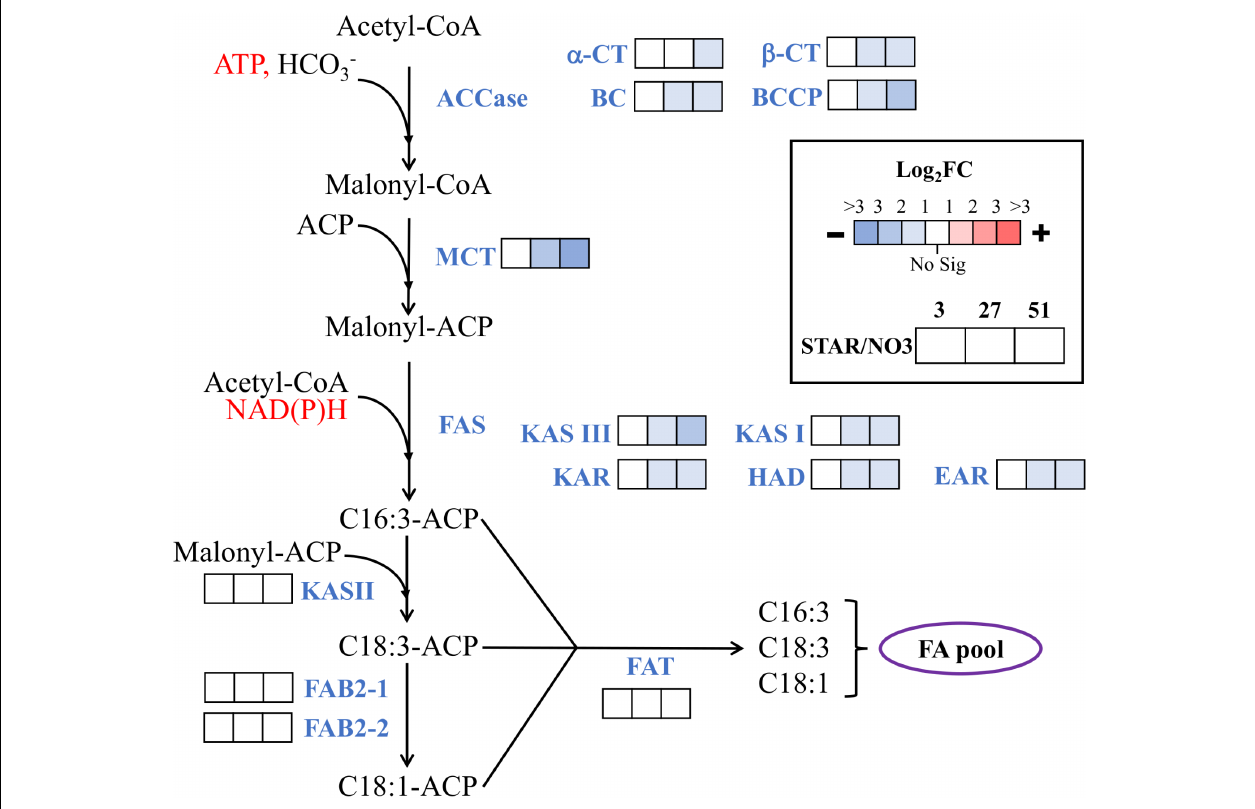
FIGURE 4 | Expression of fatty acid synthesis genes during nitrogen starvation. The log 2 fold change values are presented as STAR over NO3 for the 3, 27, and 51 h time points (left to right). Blue represents downregulation in comparison to NO3 and red is upregulation in comparison to NO3. White represents no significant differential expression. Fatty acids are labeled by the number of carbons:number of unsaturated bonds. Expression data and transcript identities are in Supplementary Data Sheet 1 . Abbreviations are as follows: CoA, coenzyme A; ACP, acyl carrier protein; ACCase, acetyl-CoA carboxylase; α -CT, α -carboxyltransferase subunit; β -CT, β -carboxyltransferase subunit; BC, biotin carboxylase subunit; BCCP, biotin carboxyl carrier protein subunit; MCT, malonyl-CoA ACP transacylase; FAS, fatty acid synthase; KAS, ketoacyl-ACP synthase; KAR, ketoacyl-ACP reductase; HAD, hydroxyacyl-ACP dehydrase, EAR, enoyl-ACP reductase; FAB2, stearoyl-ACP- (cid:49) 9-desaturase; FAT, acyl-ACP thioesterase. Modified from Srirangan et al.